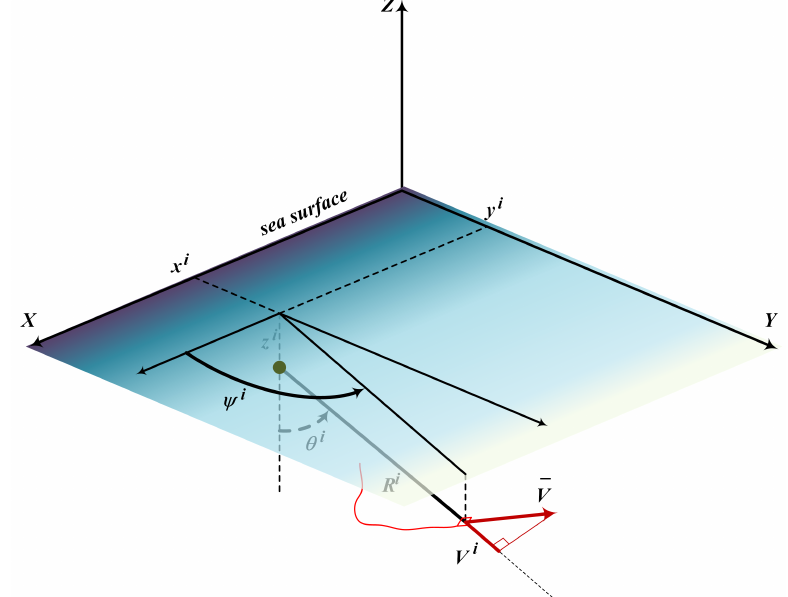
Figure 2. Bearing observations of the target from the i -th